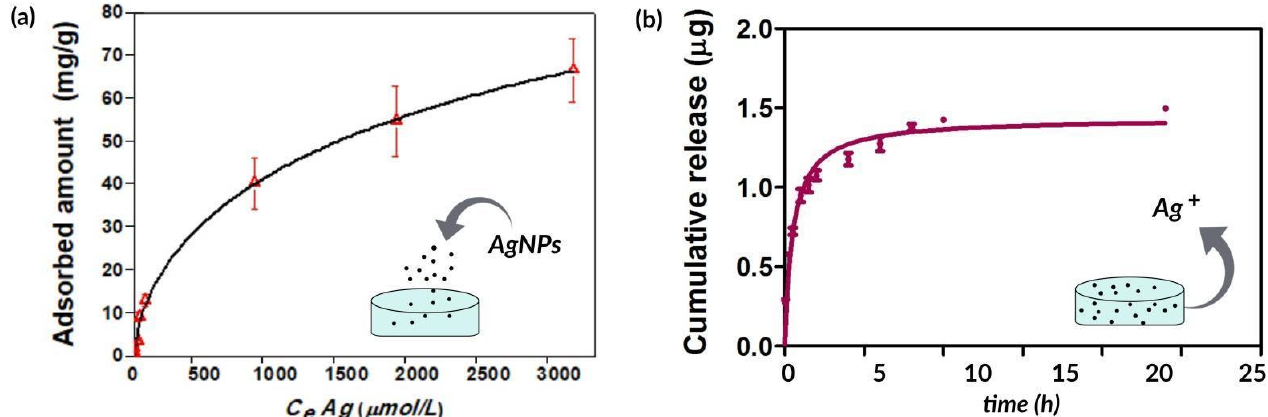
Figure 3. ( a ) Adsorption isotherm of AgNPs on collagen matrices. CeAg ( μ mol/L) corresponds to the equilibrium concen- tration of Ag. ( b ) Cumulative release of Ag + from collagen over 24 h. Results are expressed as mean ± SD from triplicate experiments.